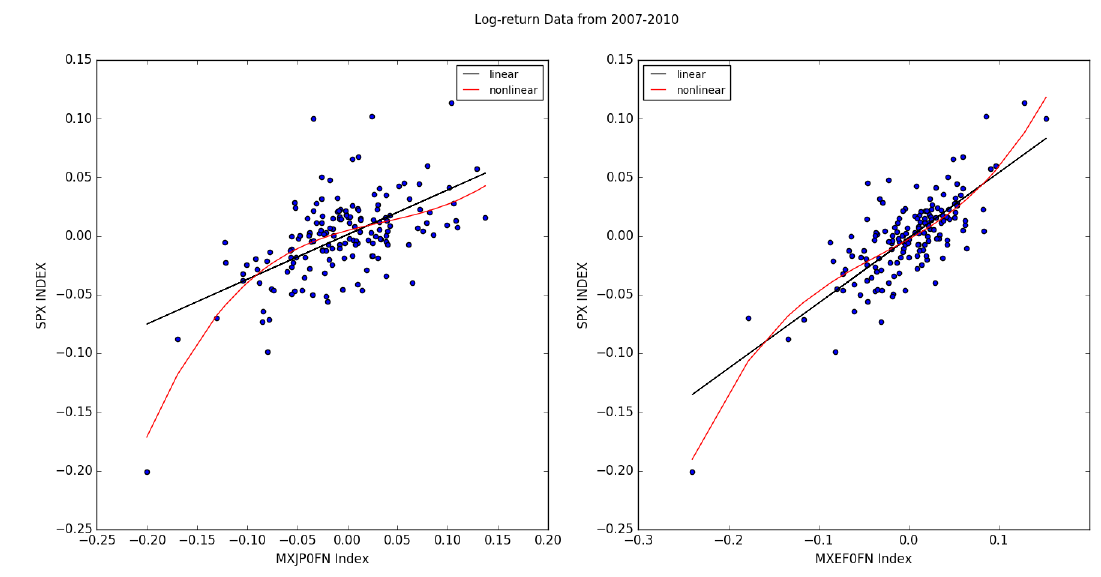
Figure 7. Linear and Nonlinear